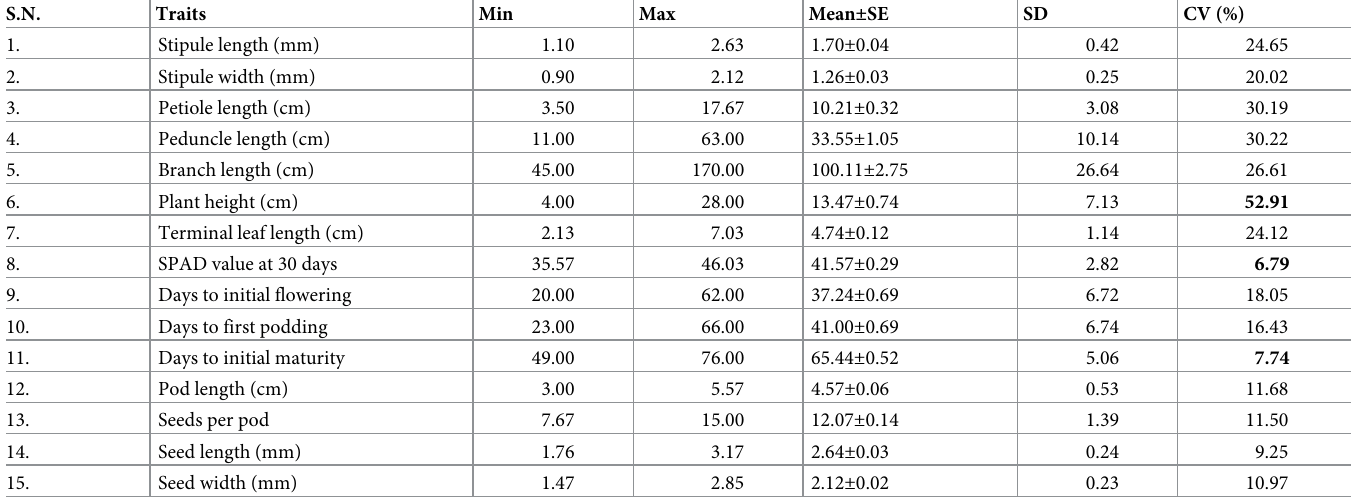
Table 2. Descriptive statistics of quantitative characters of V . stipulacea